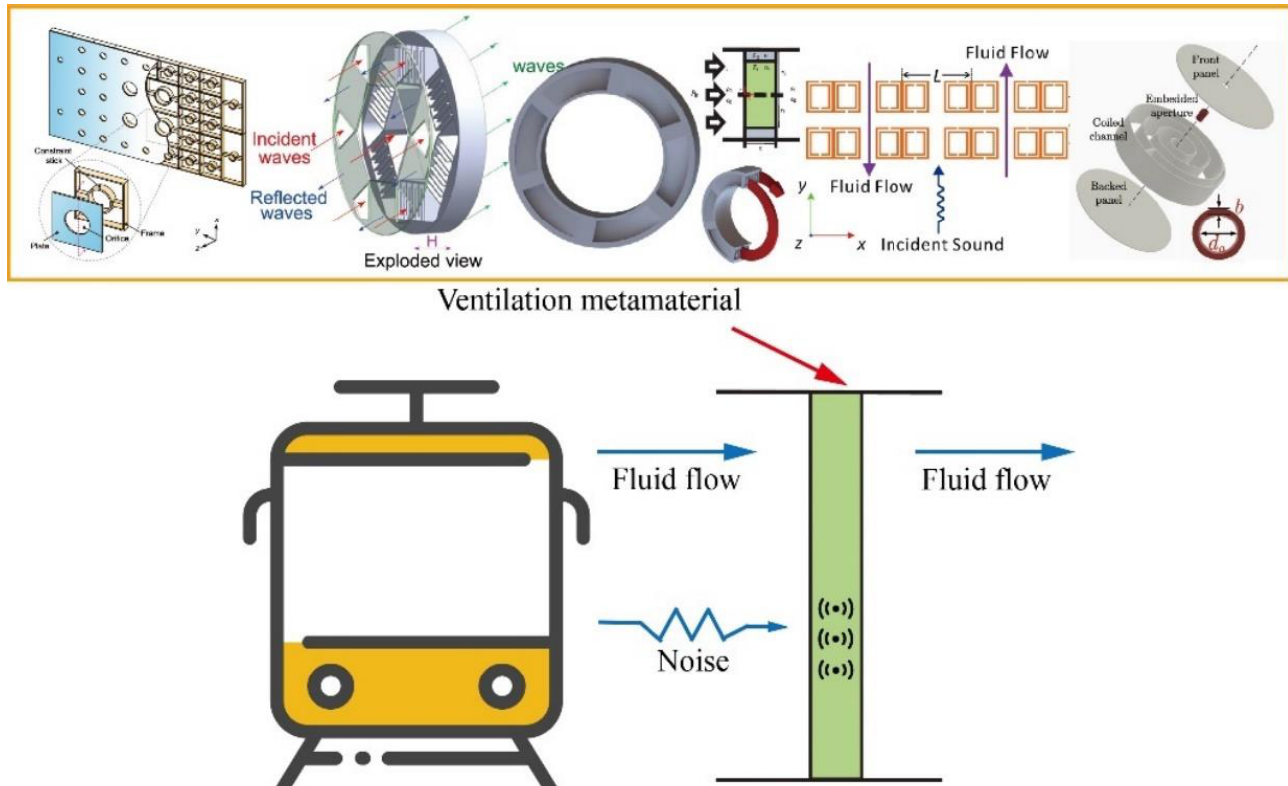
Figure 7. Acoustic metamaterials with ventilation properties applied in sound barrier.